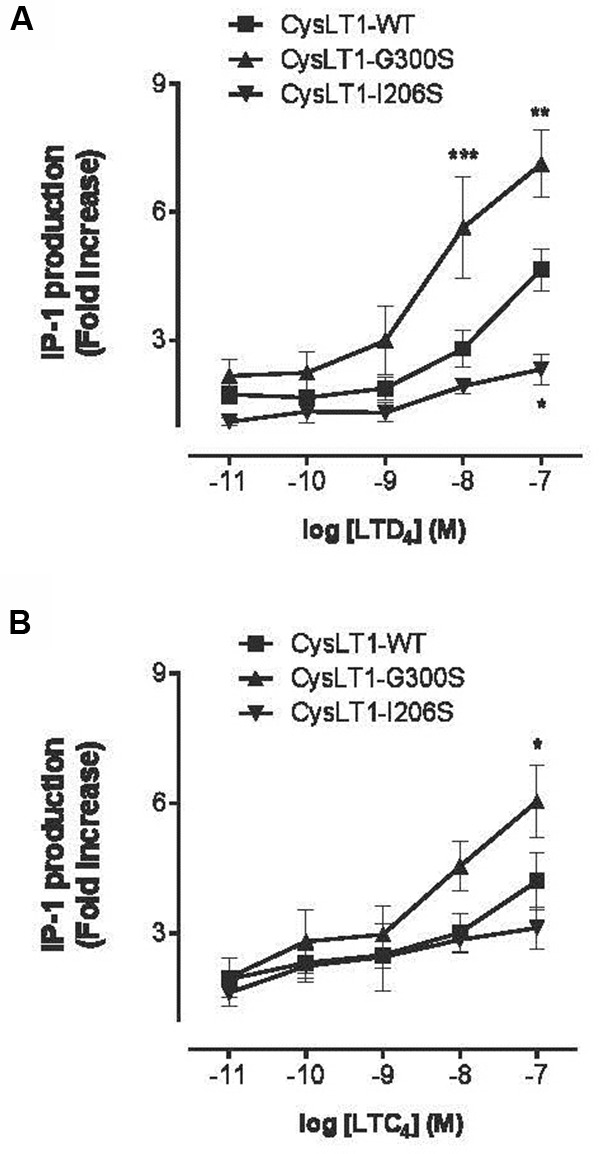
Inositol phosphate production in CYSLTR1-transfected cells. Forty-eight hours post-transfection, cells were stimulated for 30 min with LTD4 or LTC4 at 0.01–100 nM. IP-1 production was measured using an antibody against IP-1 and a fluorescent FRET IP-1 conjugate competitor. (A) IP-1 production by CYSLTR1-transfected HEK-293 cells in response to LTD4 (B) and to LTC4. Two-way ANOVA analysis; n = 6; ∗p < 0.05, ∗∗p < 0.01, ∗∗∗p < 0.001 (adapted from Yaddaden et al., 2016).